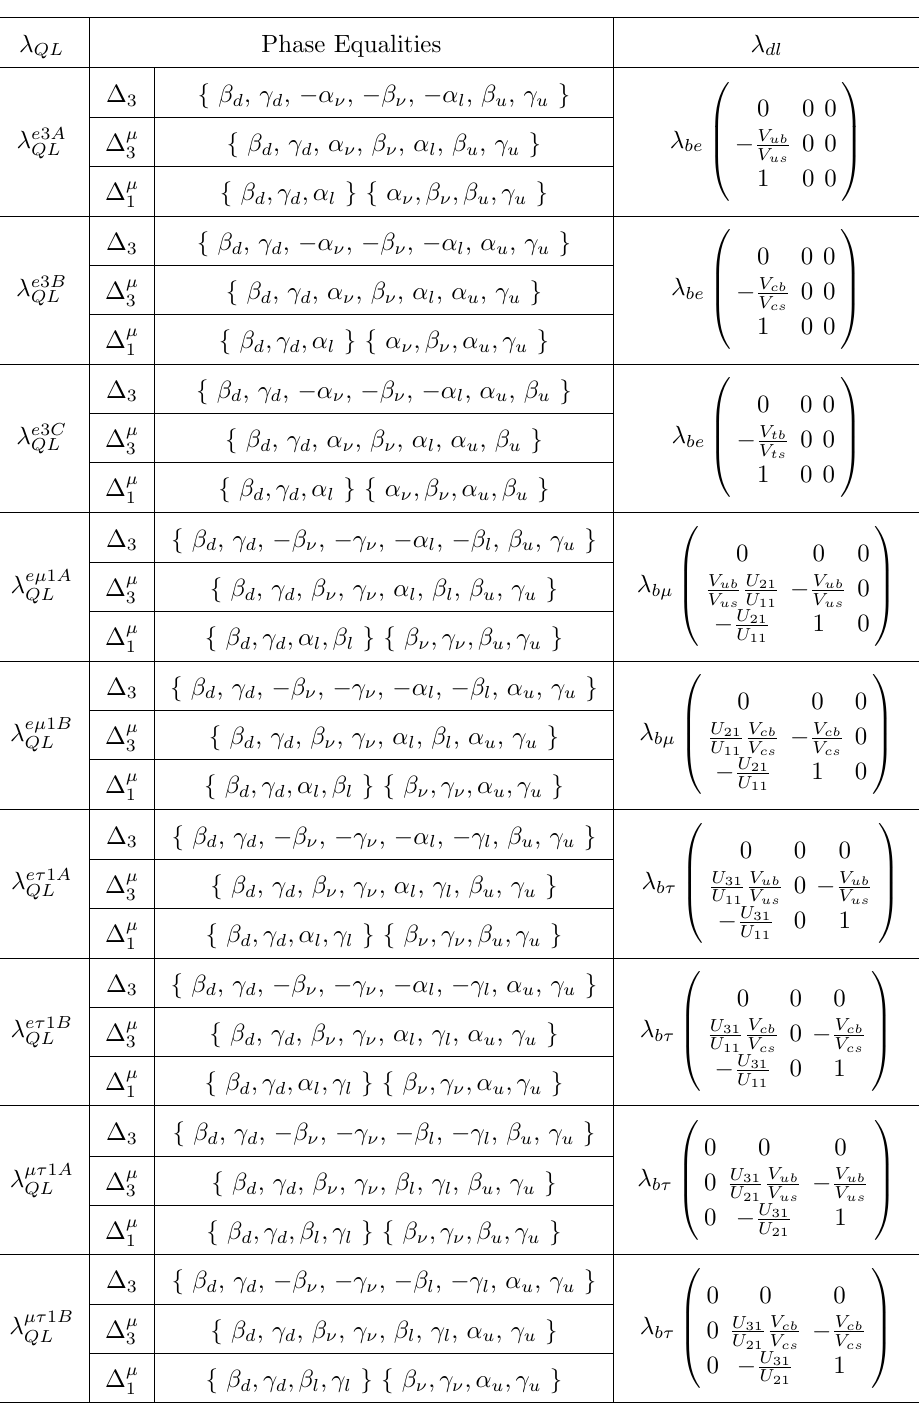
Table 2 . The ‘fully-reduced’ patterns derived in [15] after the application of SE1 symmetry and experimental constraints, including associated phase equalities required in the generators T a for all leptoquarks considered in this paper. All phases listed in brackets fg in the third column are forced to be equal to one another. NOTE: U ij (cid:17) U ij and ( U ij ) ? (cid:17) V ij . For the vectors (cid:1) (cid:22) , PMNS CKM (1 ; 3) replace V ij ! V ? ij